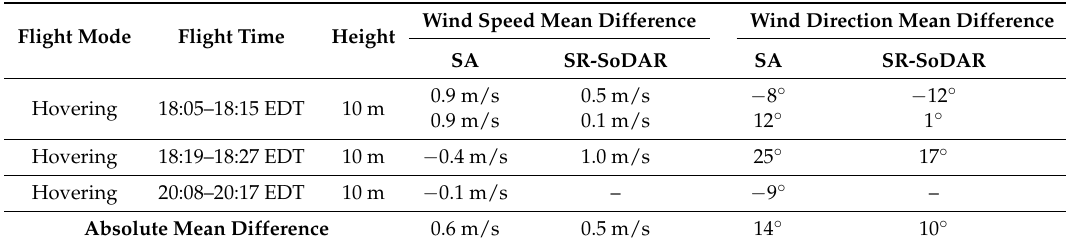
Table 10. Comparison of wind speed and wind direction observations from the quadrotor, sonic anemometer, and SR-SoDAR collected at 10 m AGL between 18:05 to 20:17 EDT on 5 June